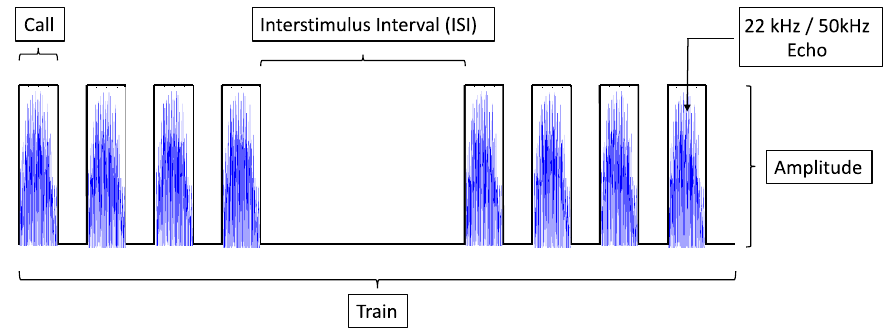
Figure 5. Design of electrical stimulation parameters; each call contains the 22 kHz/50 kHz rectified echoes, and it is repeated 11 or 26 times according to the USV type (11 calls of 0.16 s for USV at 22 kHz and 26 calls of 0.06 s for USV at 50 kHz).